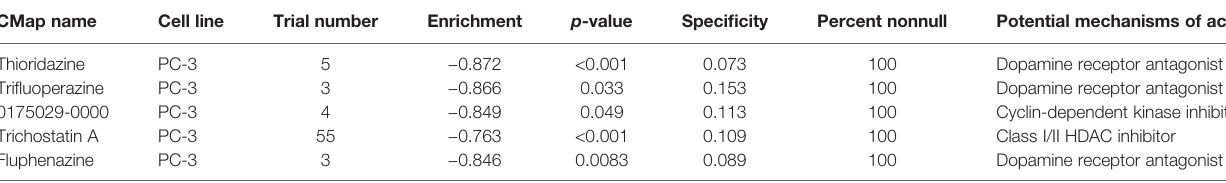
TABLE 2 | The compound (perturbagen) from the CMap after a range of